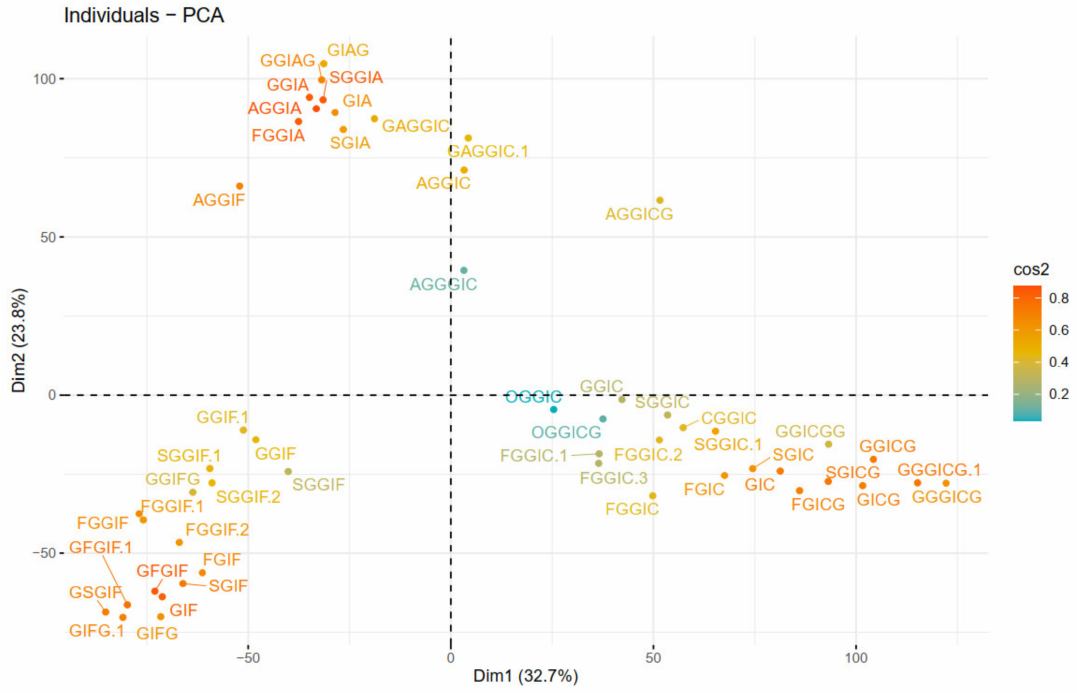
Figure 7. PCA plot of individuals